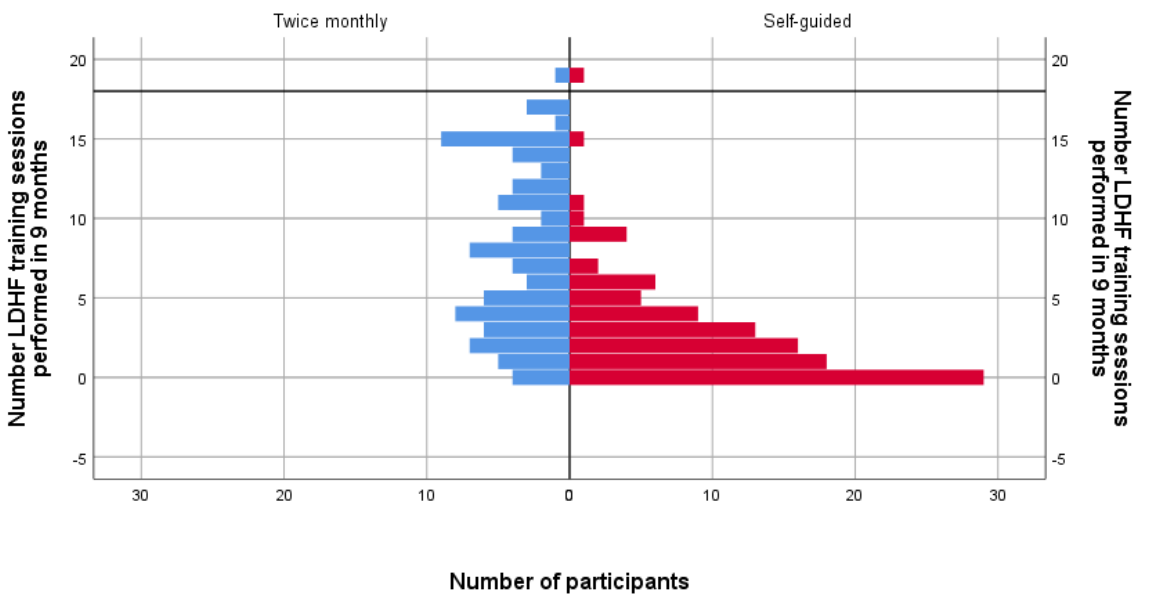
Figure 2. Population pyramid of training frequencies in the two randomisation groups. The black horizontal line indicates 18 trainings (=twice a month). LDHF = low-dose, high-frequency. T3 scores were not higher in those allocated to train twice a month compared to those training as often as desired, for either S1 ( p = 0.085) or S4 ( p = 0.067). Figure 3 show boxplots of T3 scores for both scenarios by training group.